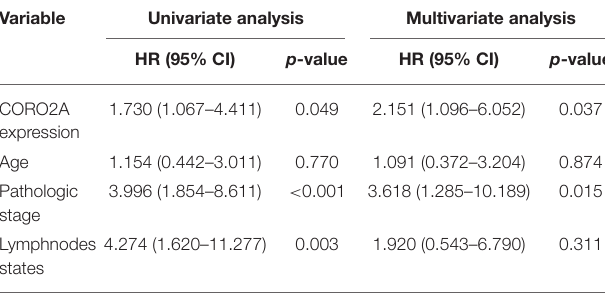
TABLE 2 | Cox proportional hazards regression analysis for OS in TNBC patients. Variable